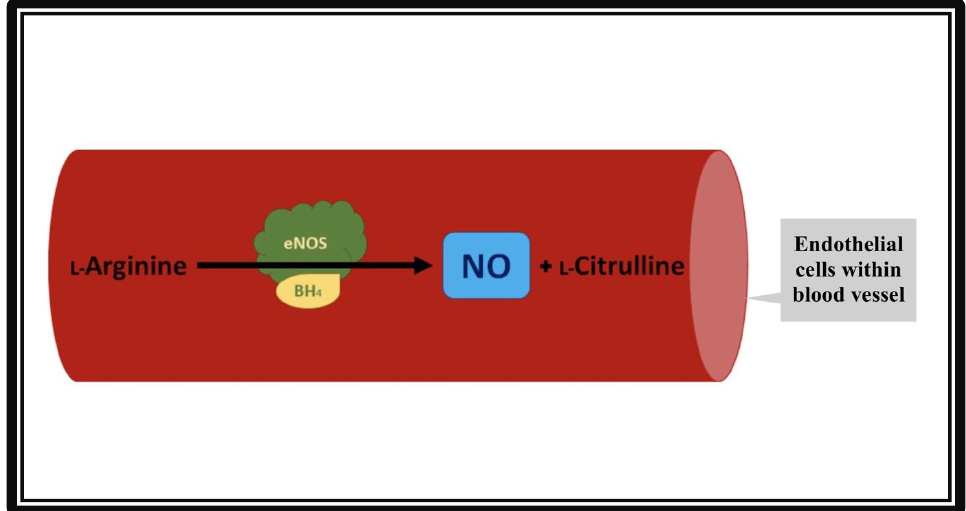
Figure 1. Formation of nitric oxide (NO) from L-Arginine in the presence of co-factor tetrahydrop- biopterin (BH 4 ) and endothelial nitric oxide synthase (eNOS). The vascular endothelial cells produce NO by utilizing eNOS. The NO then diffuses from vascular endothelia to vascular smooth muscle cells. Inside the smooth muscles, NO activates guanylate cyclase, which converts GTP to cGMP. cGMP relaxes the vascular smooth muscle cells, resulting in vasodilation.